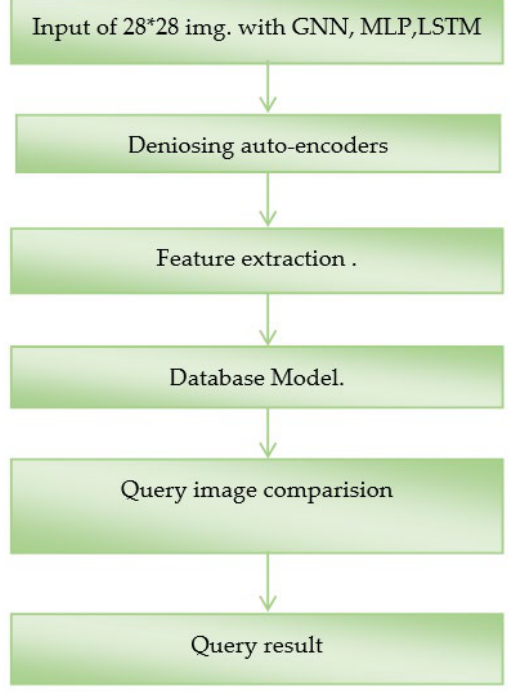
Figure 3. The flow of content-based image retrieval module.